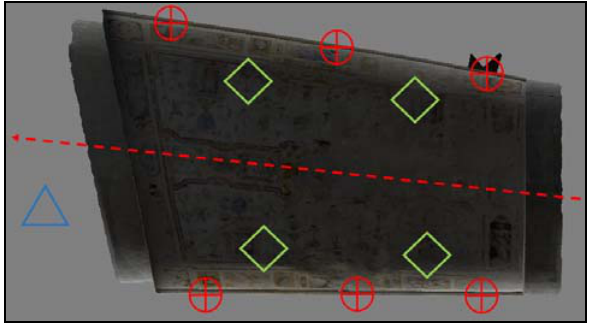
Figure 15 – Scheme of the locations of the HDS targets (red), TLS stations (green), LTS (green), as well as the traffic flow line on a plan zenithal view.